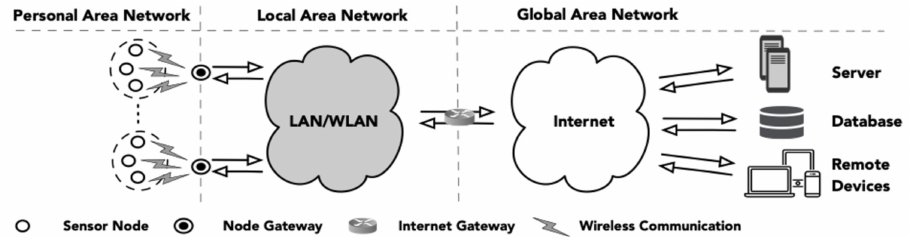
Figure 1. Overview of a typical pervasive sensing